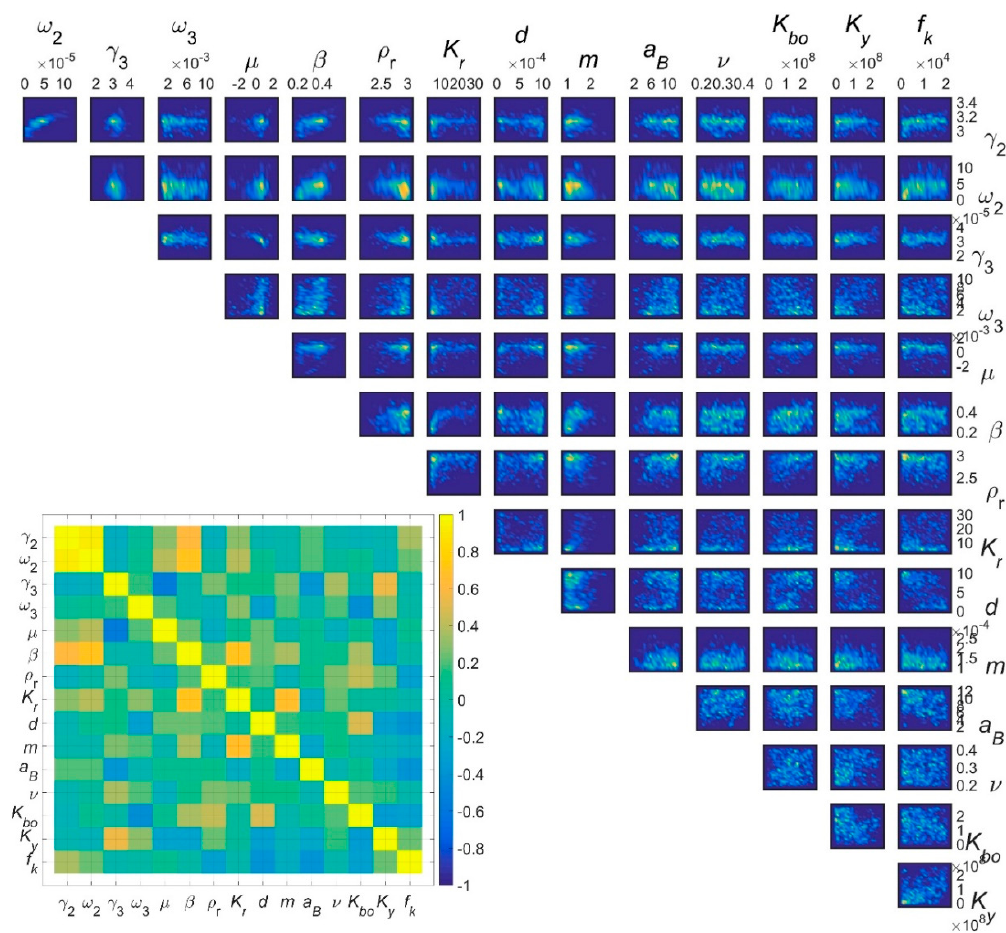
Figure 9. Estimates of two-dimensional marginal PPDs for poroelastic model parameters ( top right ) and correlation matrix map ( bottom left ).